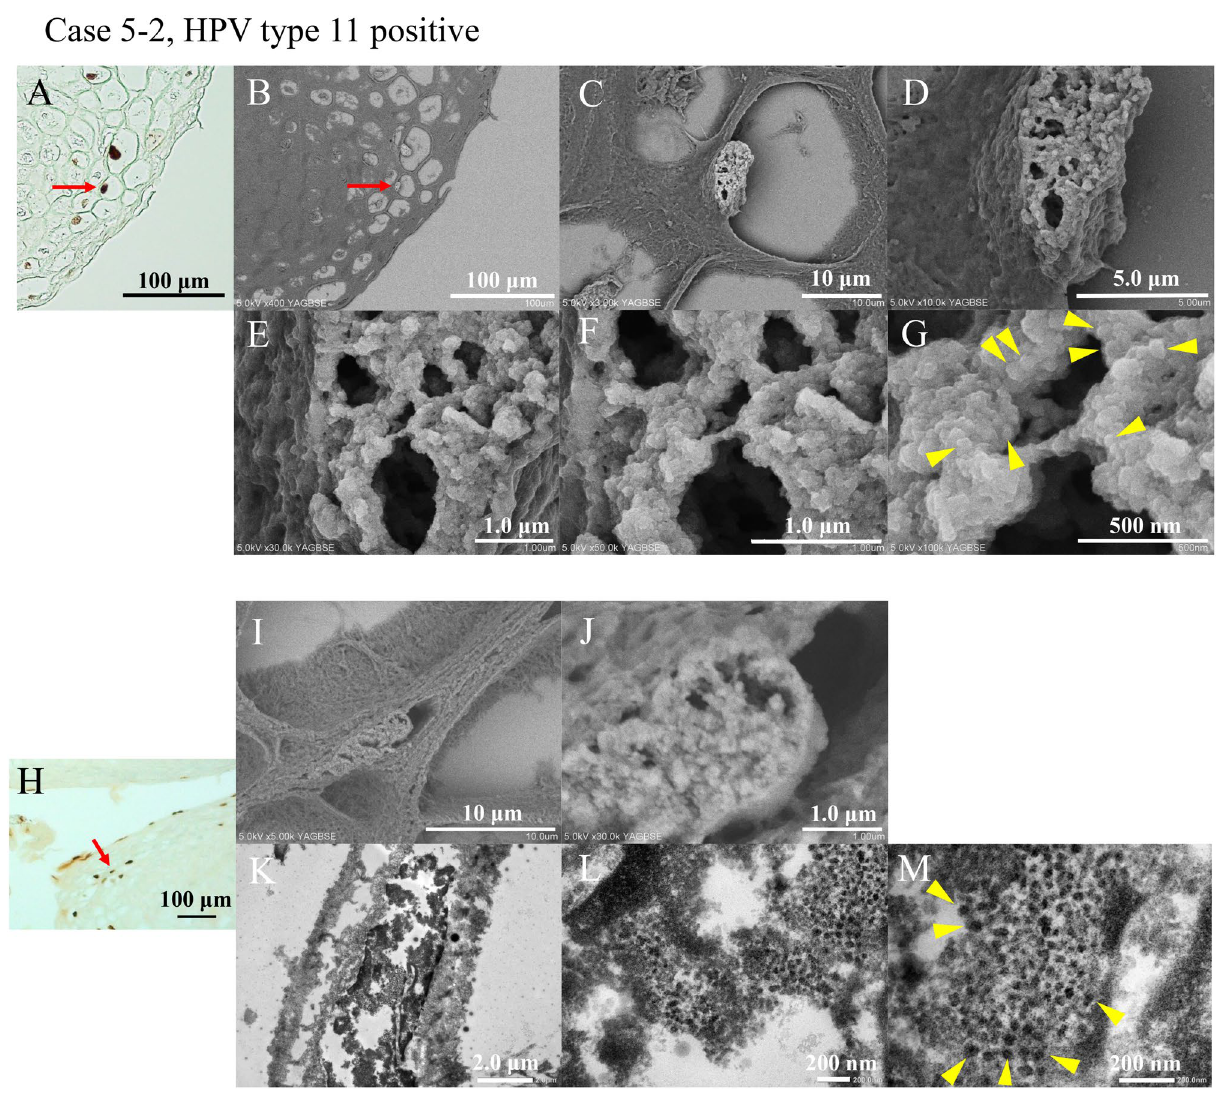
Figure 3. HPV particle detection in HPV L1-positive cells. ( A ) HPV L1 IHC is performed, and the arrow indicates the observation object. Cell nuclei are indicated by arrows. A 400 × field of view is observed. Bar indicates 100 μm. ( B – G ) HPV L1 IHC-positive cell nuclei are observed using the NanoSuit-CLEM method. The nuclei are filled with the microparticles. Typical particles of approximately 50–60 nm, the same size as the HPV particles, are indicated by arrowheads ( G ). The field of view of the images are 500 × ( B ), 3000 × ( C ), 10,000 × ( D ), 30,000 × ( E ), 50,000 × ( F ), and 100,000 × ( G ). The bars indicate 100 μm ( B ), 10 μm ( C ), 5.0 μm ( D ), 1.0 μm ( E ), 1.0 μm ( F ), and 500 nm ( G ). ( H ) HPV L1 IHC is performed. The arrow indicates the observation object. The field of view is 200 × . Bars indicate 100 μm. ( I , J ) HPV L1 IHC-positive cell nuclei are observed using the NanoSuit-CLEM method. The nuclei are filled with the microparticles. The fields of view are 5000 × ( I ) and 30,000 × ( J ). Bars indicate 10 μm ( I ) and 1.0 μm ( J ). ( K – M ) The areas are observed by the NanoSuit-CLEM method using TEM. Microparticles of approximately 50–60 nm in size are observed in the nucleus and determined to be HPV particles. Representative HPV particles are indicated with arrowheads ( M ). Magnification is 5000 × ( K ), 30,000 × ( L ), and 50,000 × ( M ). The bars indicate 2.0 μm ( K ), 200 nm ( L ), and 200 nm ( M ). CLEM Correlative light and electron microscopy, HPV Human papillomavirus, IHC